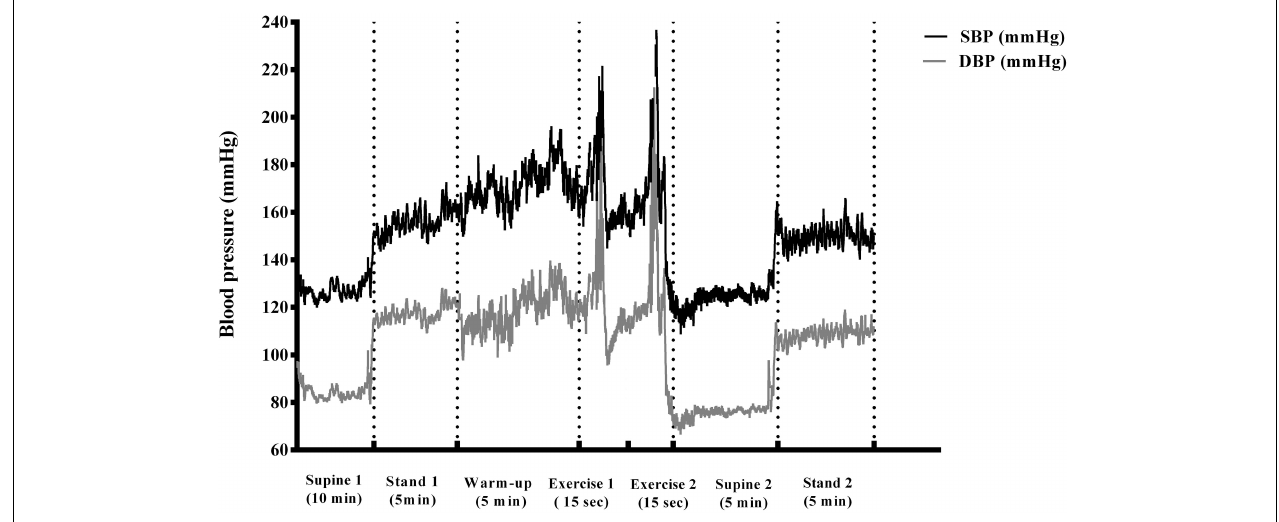
FIGURE 1 | A schematic illustration of the study protocol shown as a typical blood pressure trace recorded throughout the exercise intervention from one participant. Briefly, different phases of the experimental protocol are depicted ( supine 1-baseline, stand 1, stepping warm-up, mounting, exercise 1, rest, exercise 2, supine 2, stand 2